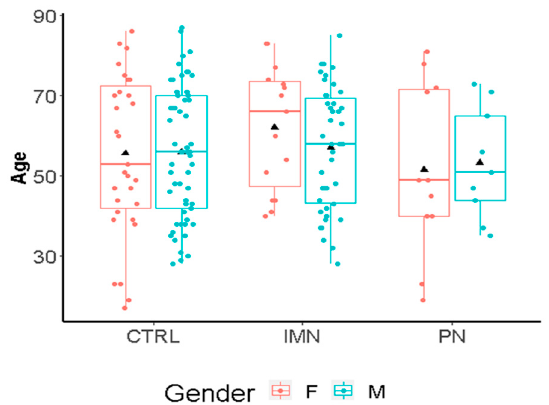
Figure 1. Age distribution by gender and groups (IMN = Idiopathic Membranous Nephropathy; CTRL = healthy controls; PN = pathological controls with non-IMN nephropathy). Age refers to years. The black triangle represents the average.